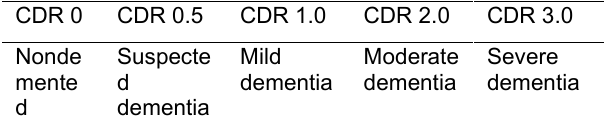
Table 2 Diagnostic criteria for CDR